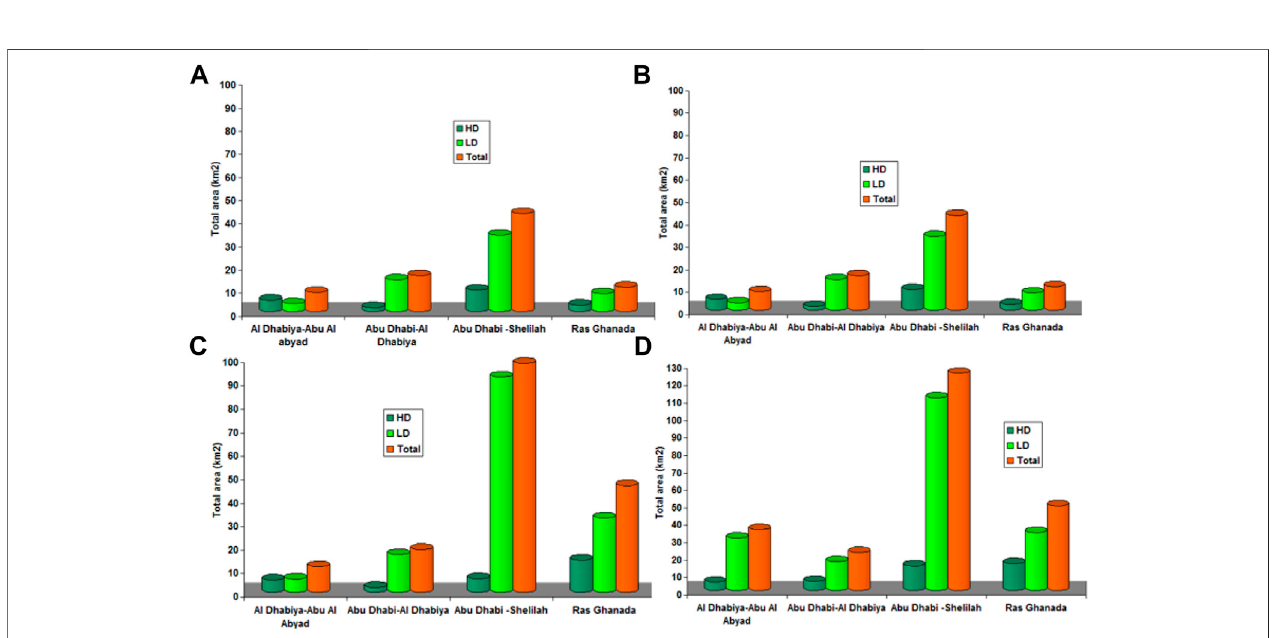
Frontiers in Remote Sensing |